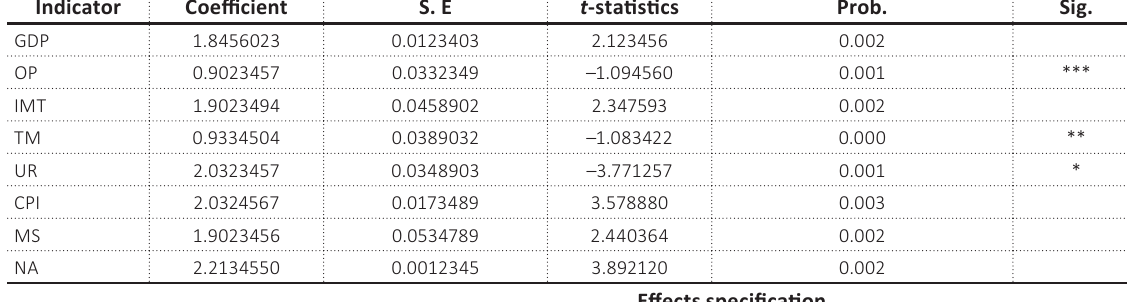
Table 5. Panel regression analysis (vulnerability scenario)